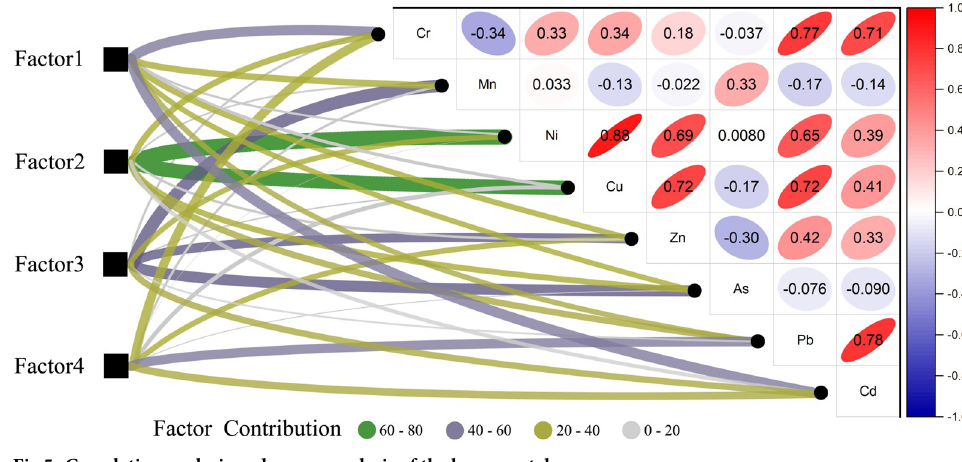
Fig 5. Correlation analysis and source analysis of the heavy